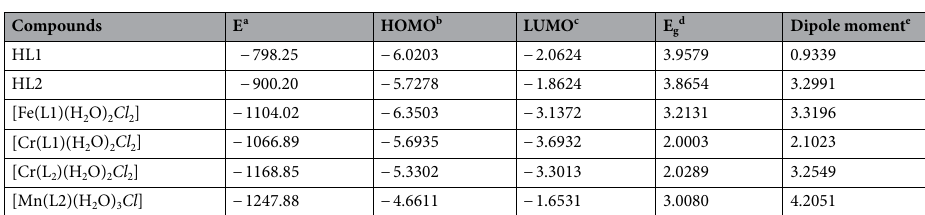
Table 9. Calculated energies of two ligands and their complexes. a E the total energy (a. u.). b HOMO highest occupied molecular orbital (eV). c LUMO lowest unoccupied molecular orbital (eV). d E g = E LUMO − E HOMO (eV). e dipole moment